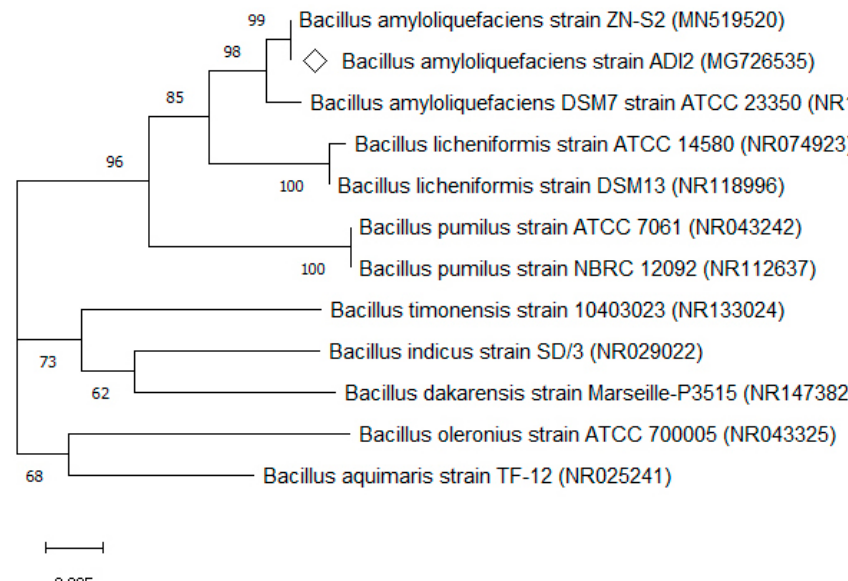
Figure 1. Phylogenetic correlation between B. amyloliquefaciens ADI2 and other Bacillus sp. as per the neighbour-joining approach. The bar depicts the number of nucleotide substitutions per site. The bootstrap value is attained via 1000 replications and each value is displayed at the respective nodes. The respective name and accession number of nodes are given in the tree.